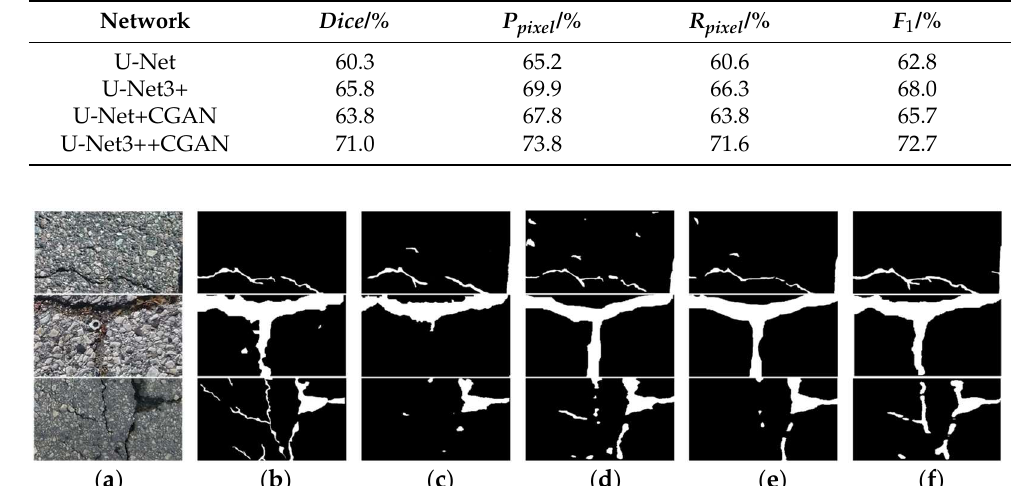
Table 3. The results of different networks.